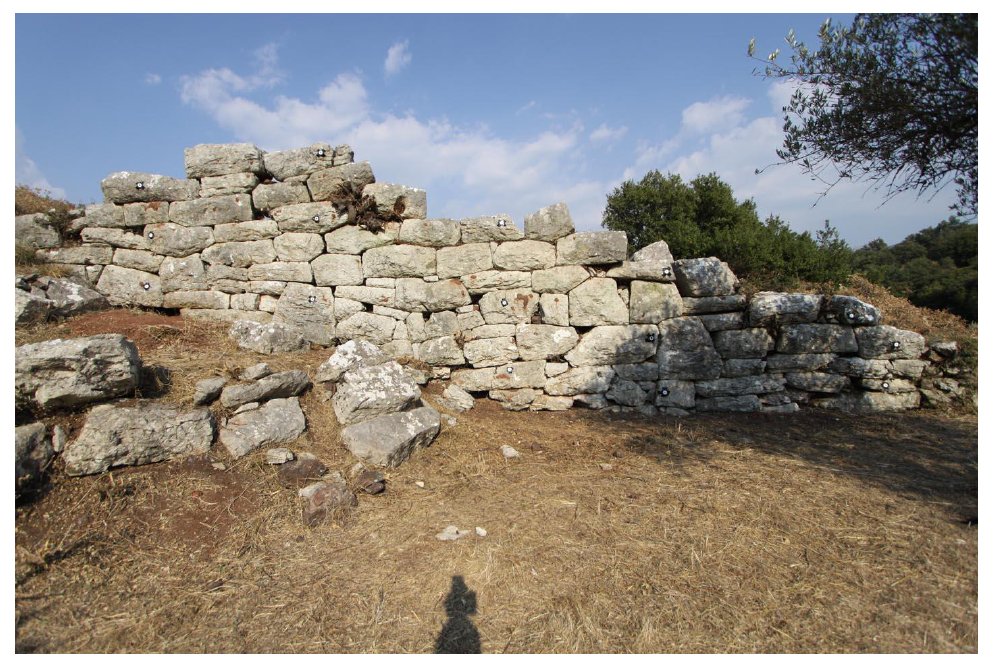
Figure 8. Appearance of city wall.